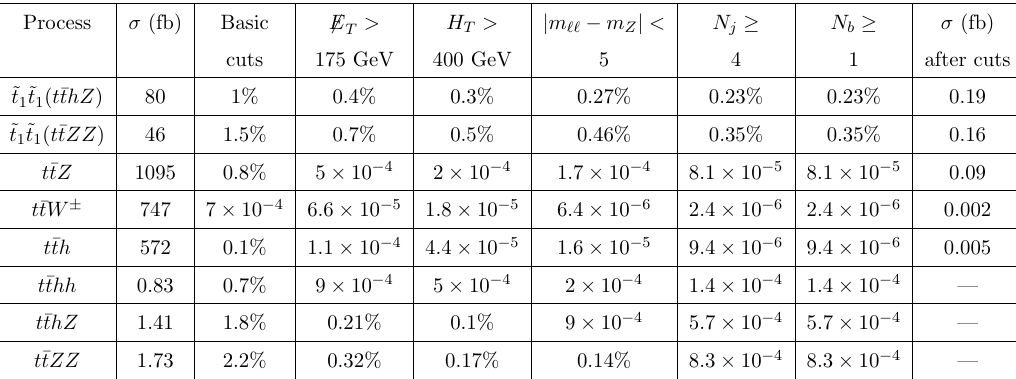
Table 7 . Cumulative cut e(cid:14)ciencies after each level of advanced seletion cuts and cross sections for t (cid:22) thZ E E the signal ~ t 1 ~ t (cid:3) and t (cid:22) tZZ as well as SM backgrounds in the T T 1 ! 6 6 at the 14 TeV LHC. The t (cid:22) thh has no reach sensitivity because of the extremely low branching fraction of three leptons channel. The t (cid:22) t and t (cid:22) tb (cid:22) b processes are also not listed since they are highly suppressed after all the cuts.